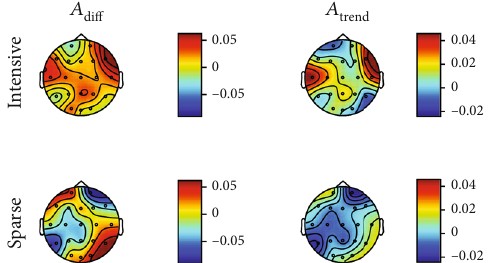
Figure 3: Topographic distribution of median A (equation (3)) measures for the INTENSIVE and and A trend SPARSE groups across sessions for the upper alpha (UA) band.